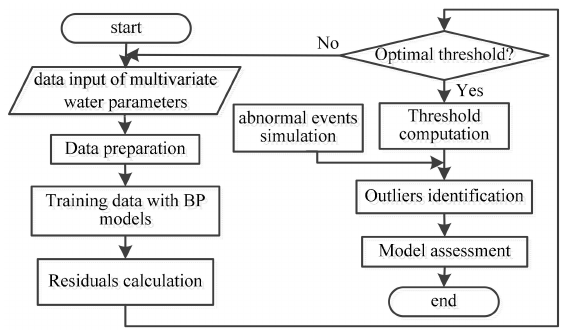
Figure 2. Procedure in the off-line phase.